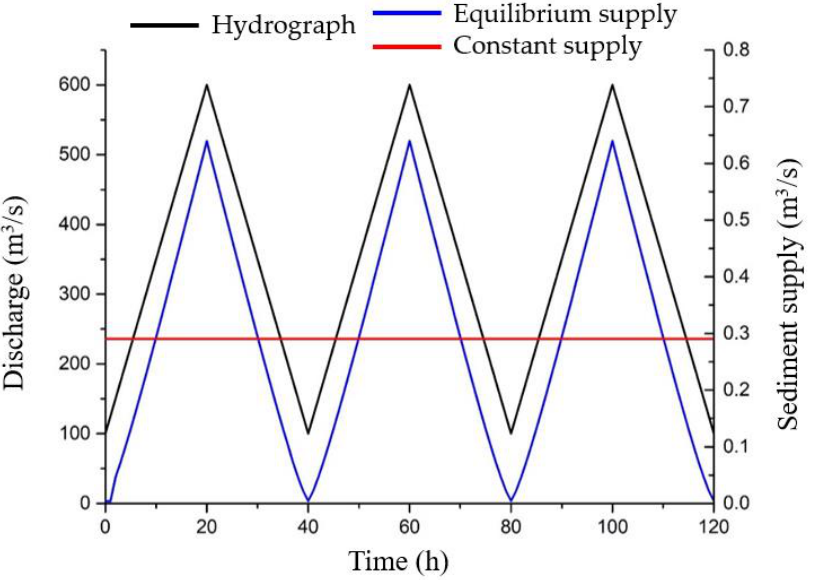
Figure 1. Hydrograph and sediment supply conditions used for the base calculation (Case 1). The three hydrographs are shown here as an example, but in the calculation, 50 hydrographs were ob- tained.